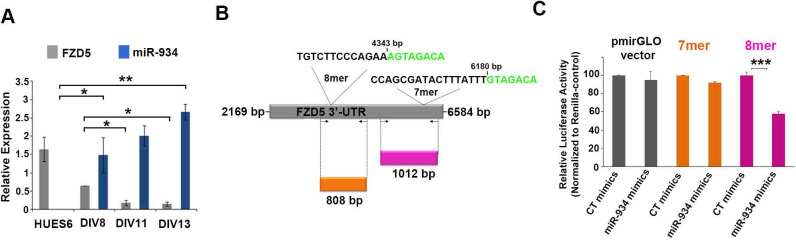
Identification of an 8mer-seed sequence as binding site for miR-934 on the 3'-UTR of Fzd5.(A) RT-qPCR analysis at different time points of neural induction, showing up-regulation of miR-934 and parallel down-regulation of the mRNA of its predicted target, Fzd5. Using the DIANA-microT-CDS target prediction algorithm, two putative MREs were identified on the 3'-UTR of Fzd5. (B) Schematic representation of Fzd5 3’-UTR depicting in green characters the seed-binding sequences of the two predicted MREs for miR-934 with their respective positions. To examine mechanistically the inhibition exerted by miR-934 on Fzd5 expression, a luciferase reporter system was used to evaluate independently the binding of miR-934 on each of the 2 MREs which contain either a 7mer (binding score: 0.032), or an 8-mer (binding score: 0.005) site. Shown in color code are the sequences and sizes of Fzd5 3’-UTR regions containing the 2 MREs, as they were cloned into the pmirGLO vector (orange: 7mer; magenta: 8mer). Arrows indicate primer sites for cloning. Fragments of the 3'-UTR of Fzd5 containing each of the two possible binding domains for miR-934 (1012 bp, including the 7mer sequence; and 808 bp including the 8-mer sequence) were cloned separately into the 3'-UTR of the dual luciferase reporter construct pmirGLO. (C) Upon co-transfection of HEK293T cells with miR-934 mimics and the different Fzd5 reporter constructs, luciferase activity was only suppressed in the construct (808 bp) containing the 8mer site sequence (p=0.000008). Color code as in (A).